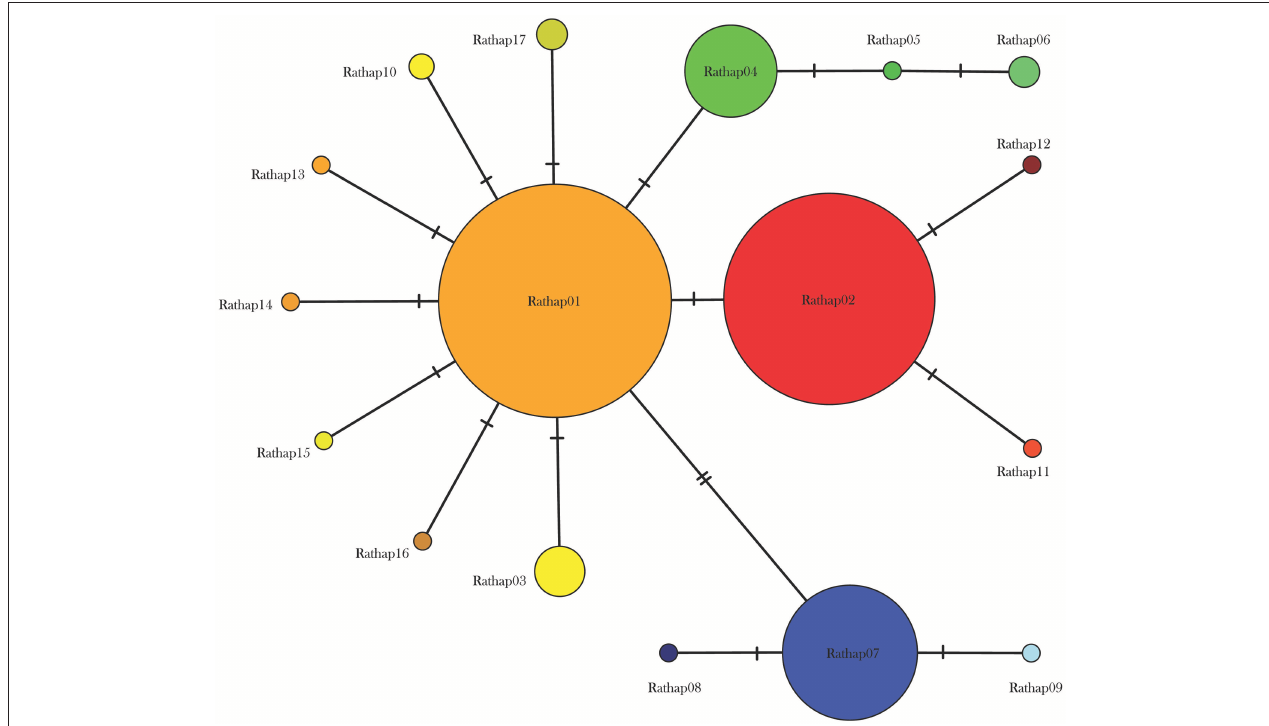
FIGURE 3 | Median joining haplotype network for 425 R. rattus individuals from across the New Zealand archipelago.